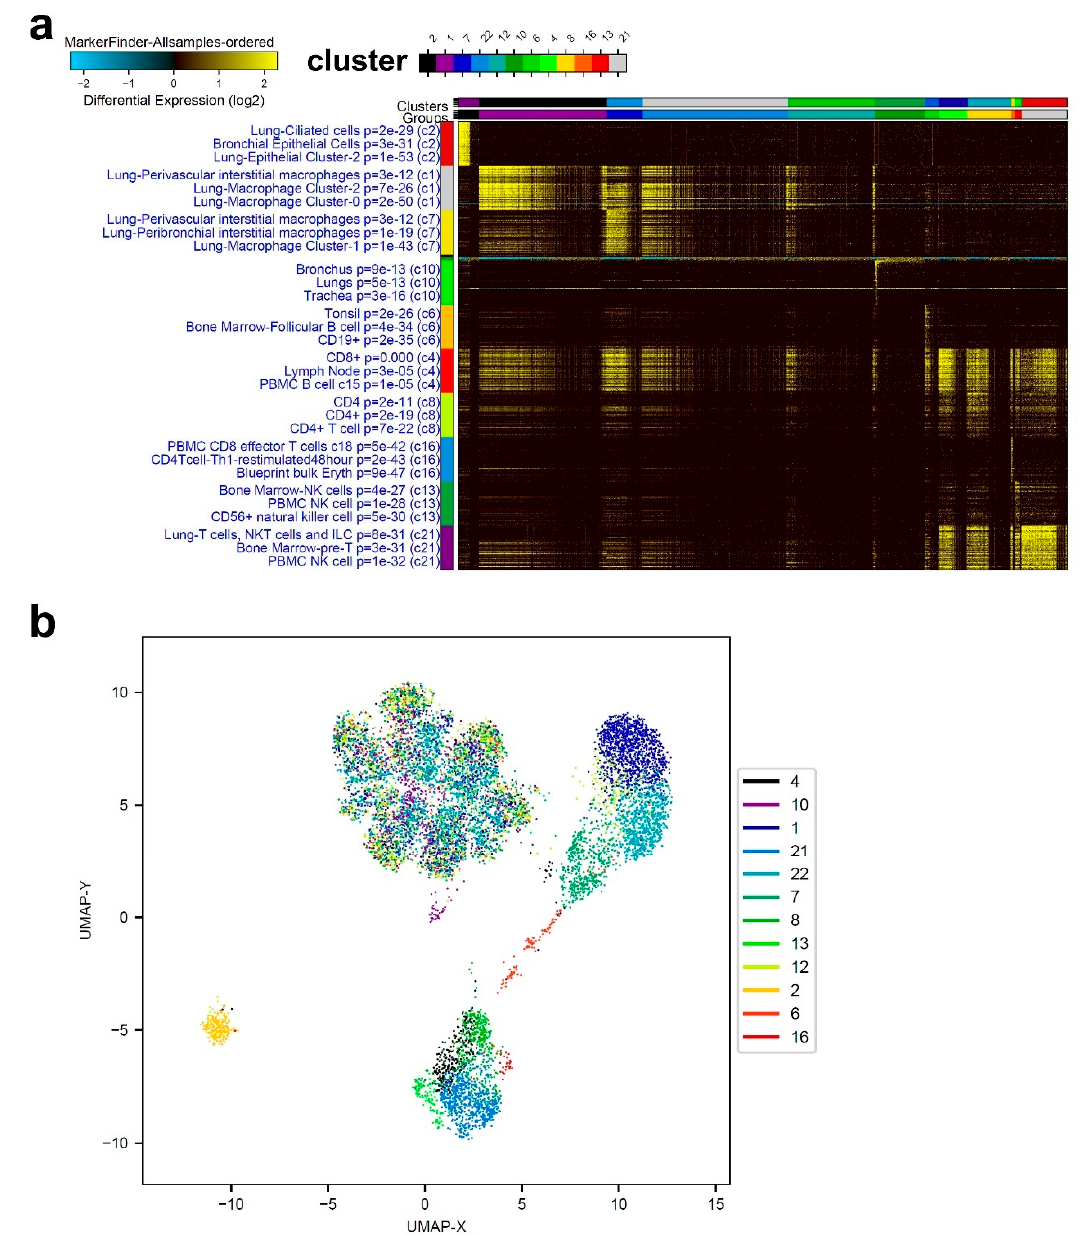
Figure 2. Representative single-cell analysis of BAL from a mild COVID-19 patient. ( a ) Representative single-cell analysis of BAL from a mild-COVID-19 patient employing the ICGS2 algorithm depicted as heat map. ( b ) UMAP dimensionality reduction visualization of cell clusters corresponding to data presented in panel a.